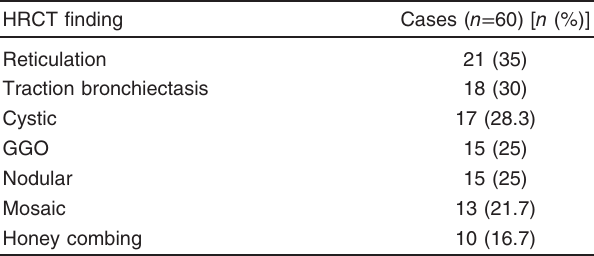
Table 2 Represent high-resolution computed tomography findings in studied patients HRCT finding